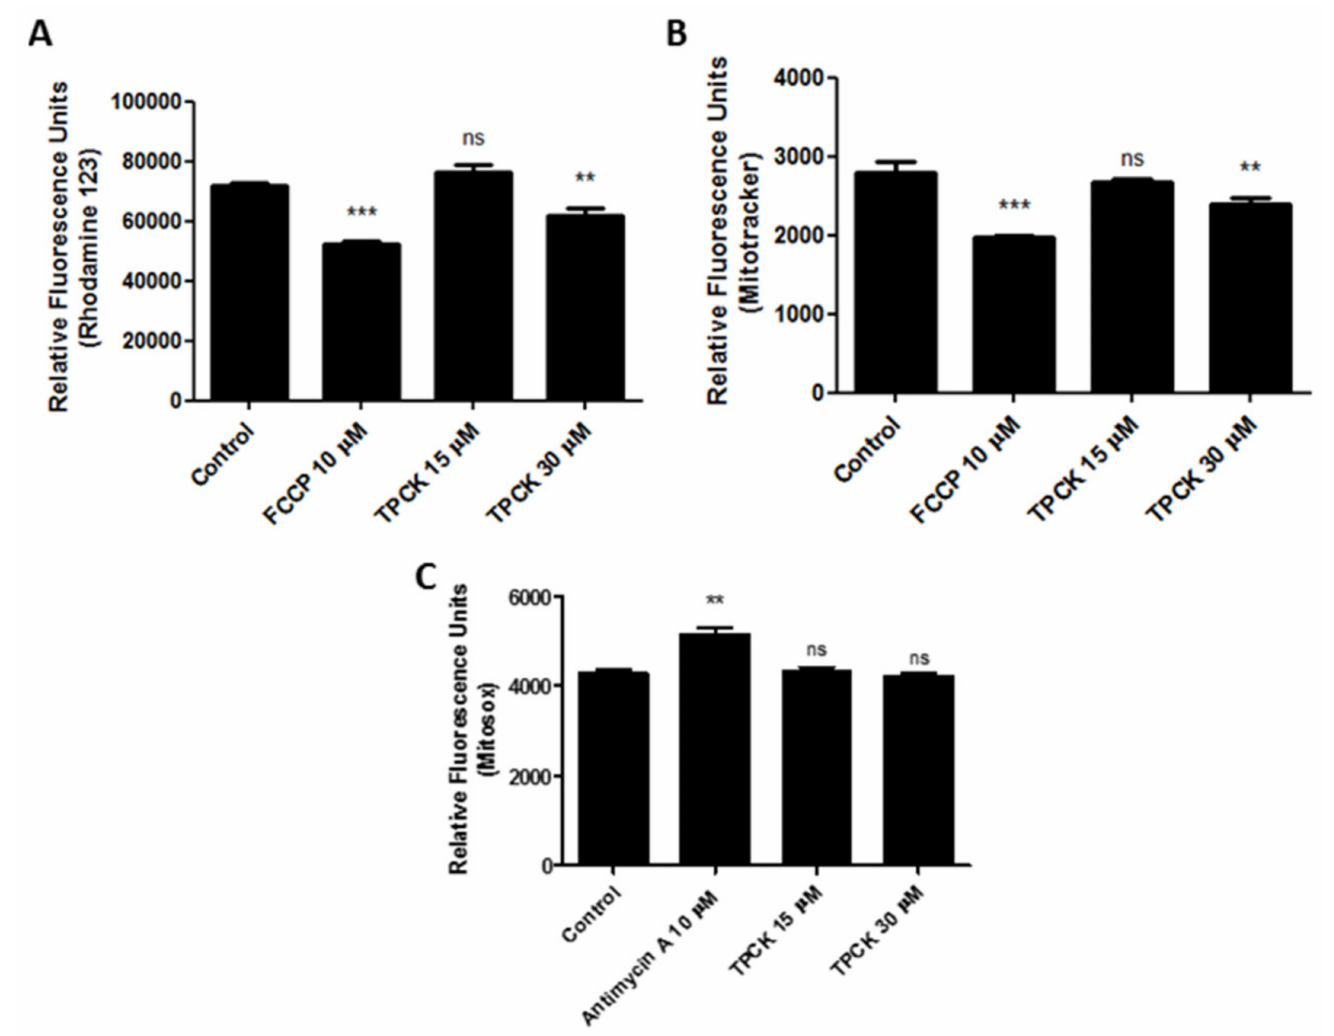
Figure 4. TPCK treatment effects on the mitochondria of L. amazonensis promastigotes. L. amazo- nensis promastigotes were treated with TPCK (15 and 30 µ M) for 24 h and then stained with either ( A ) rhodamine 123; ( B ) MitoTracker Red; or ( C ) MitoSox. TPCK concentrations correspond to the 1- and 2-fold IC 50 values after 72 h of incubation. FCCP at 10 µ M was used as the positive control in ( A , B ) and antimycin A at 10 µ M in ( C ). Statistical analyses were performed by a one-way ANOVA followed by Tukey’s post-test to compare the untreated control group with the other treatments: *** p < 0.001, ** p < 0.01, and ns—not significant. Interestingly, decreased lipid content in L. amazonensis promastigotes treated with TPCK at 30 µ M was noted (Figure 5C,D). This was observed for both neutral lipids (read- ings taken at 485/528 nm—green fluorescence) (Figure 5C; RFU: ~3200 in control and ~2300 in 30 µ M TPCK) and polar lipids/phospholipids (readings taken at 540/600 nm—red fluo- that the lipid content is significantly altered after TPCK treatment. Miltefosine (21 µ M) was used as a positive control and increased the Nile Red fluorescence in both readings (Figure